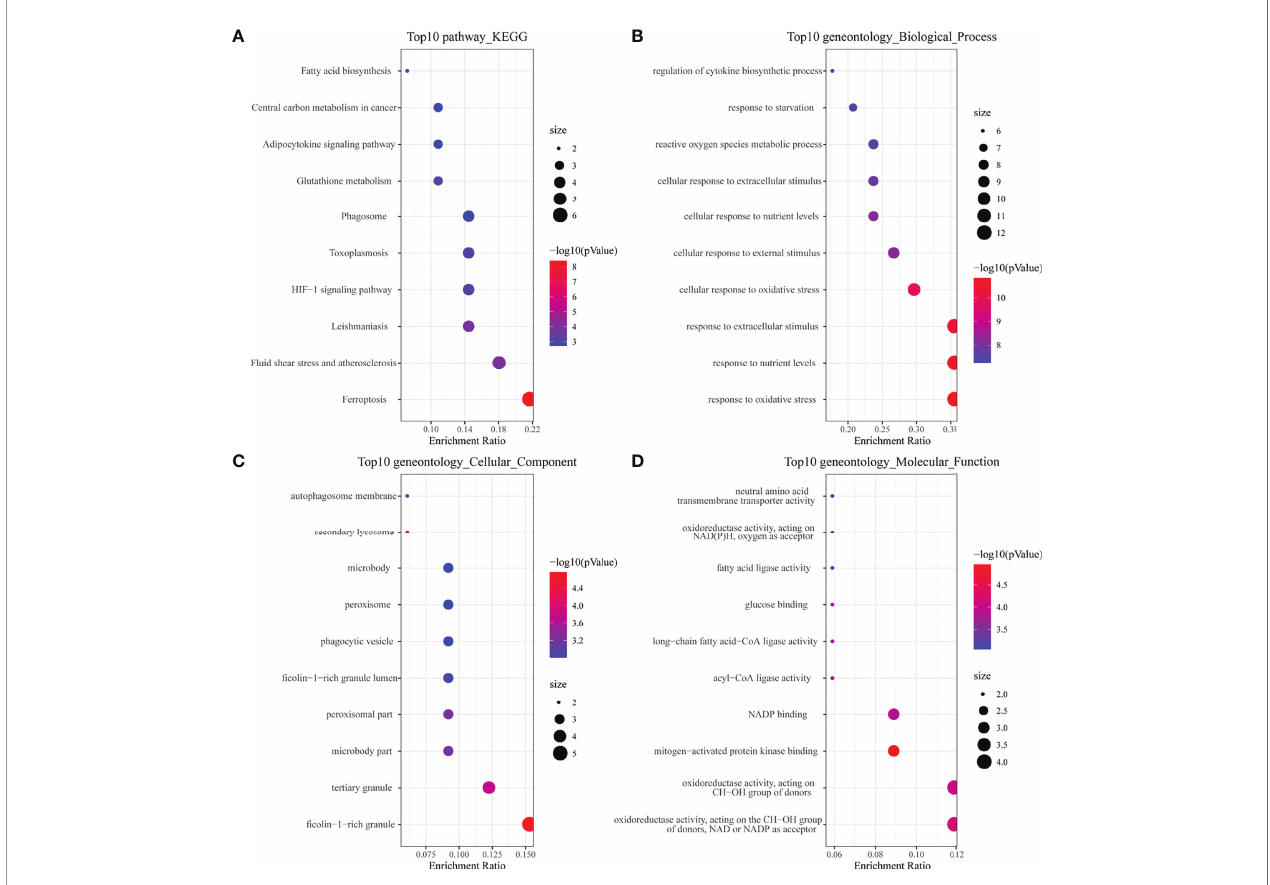
FIGURE 2 | Enrichment analysis of ferroptosis-related DEGs. (A) Top 10 KEGG pathway. (B) Top 10 GO (gene ontology) biological processes pathway. (C) Top 10 GO cellular component pathway. (D) Top 10 GO molecular function